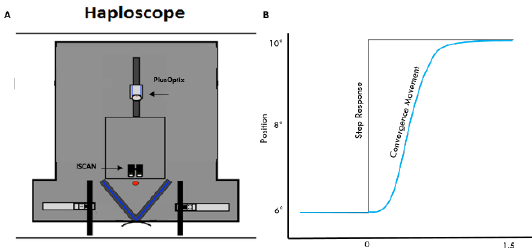
Figure 2A: The haploscope design used to present stimuli in separate visual fields to participants. 2B: experimental protocol illustrating the presentation of stimulus and vergence eye movements induced utilizing a